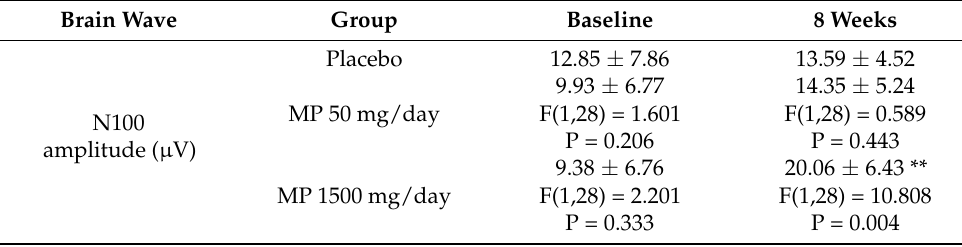
Table 2. The effect of various doses of the developed supplement containing the combined extract of Polygonum odoratum and Morus alba leaves on event-related potential